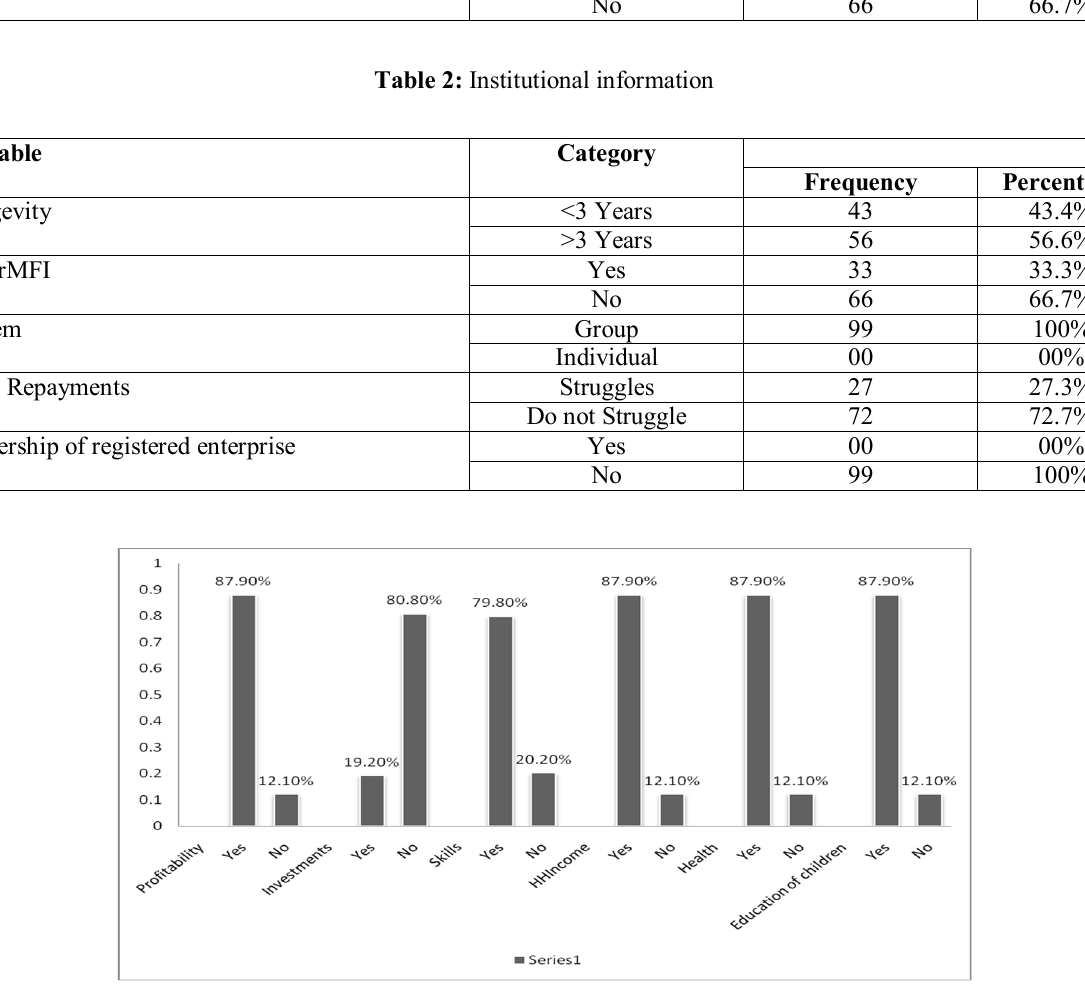
Figure 2: Perception of the respondents on household improvement based on microfinance